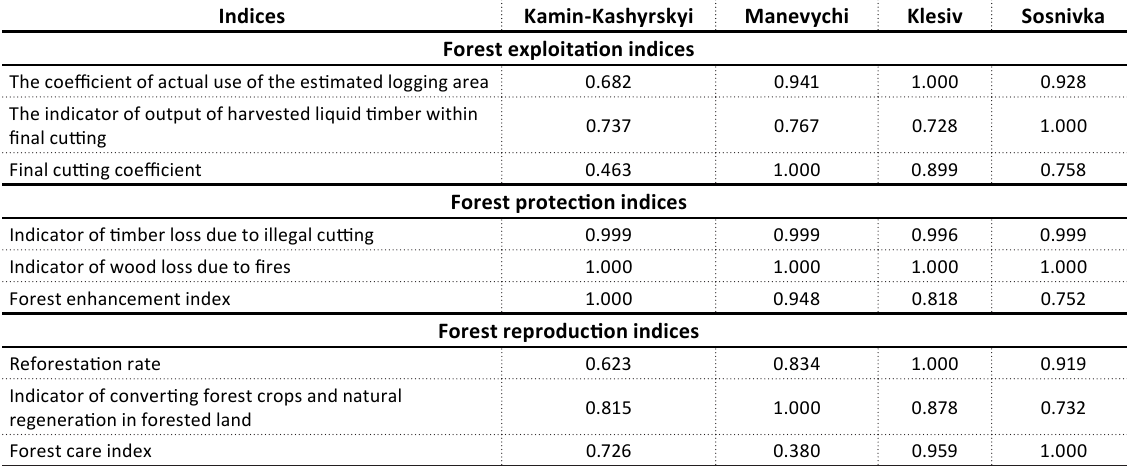
Source: A. Cherchyk’s